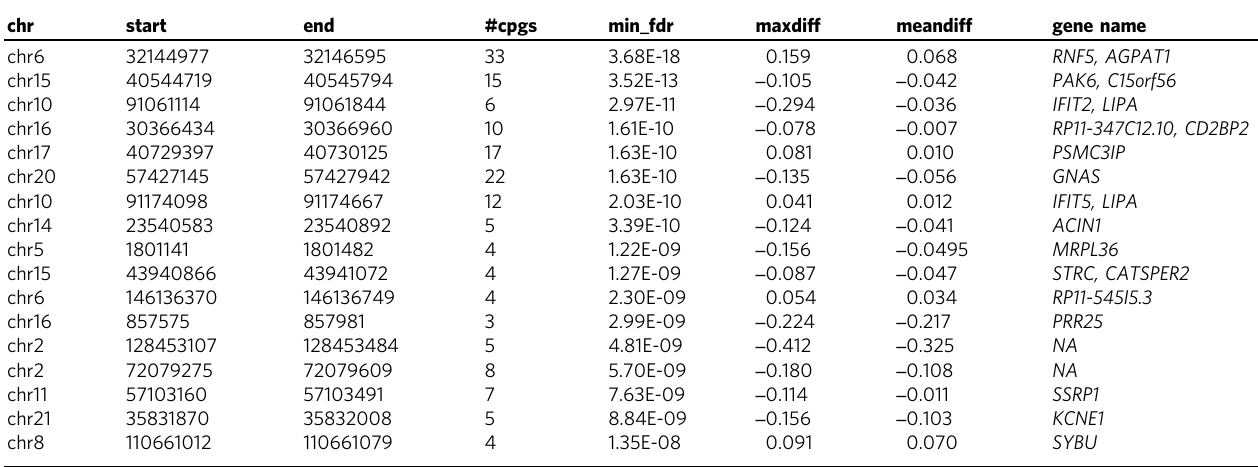
Table 3 List of the DMRs detected using DMRCate at q-value < 0.25.